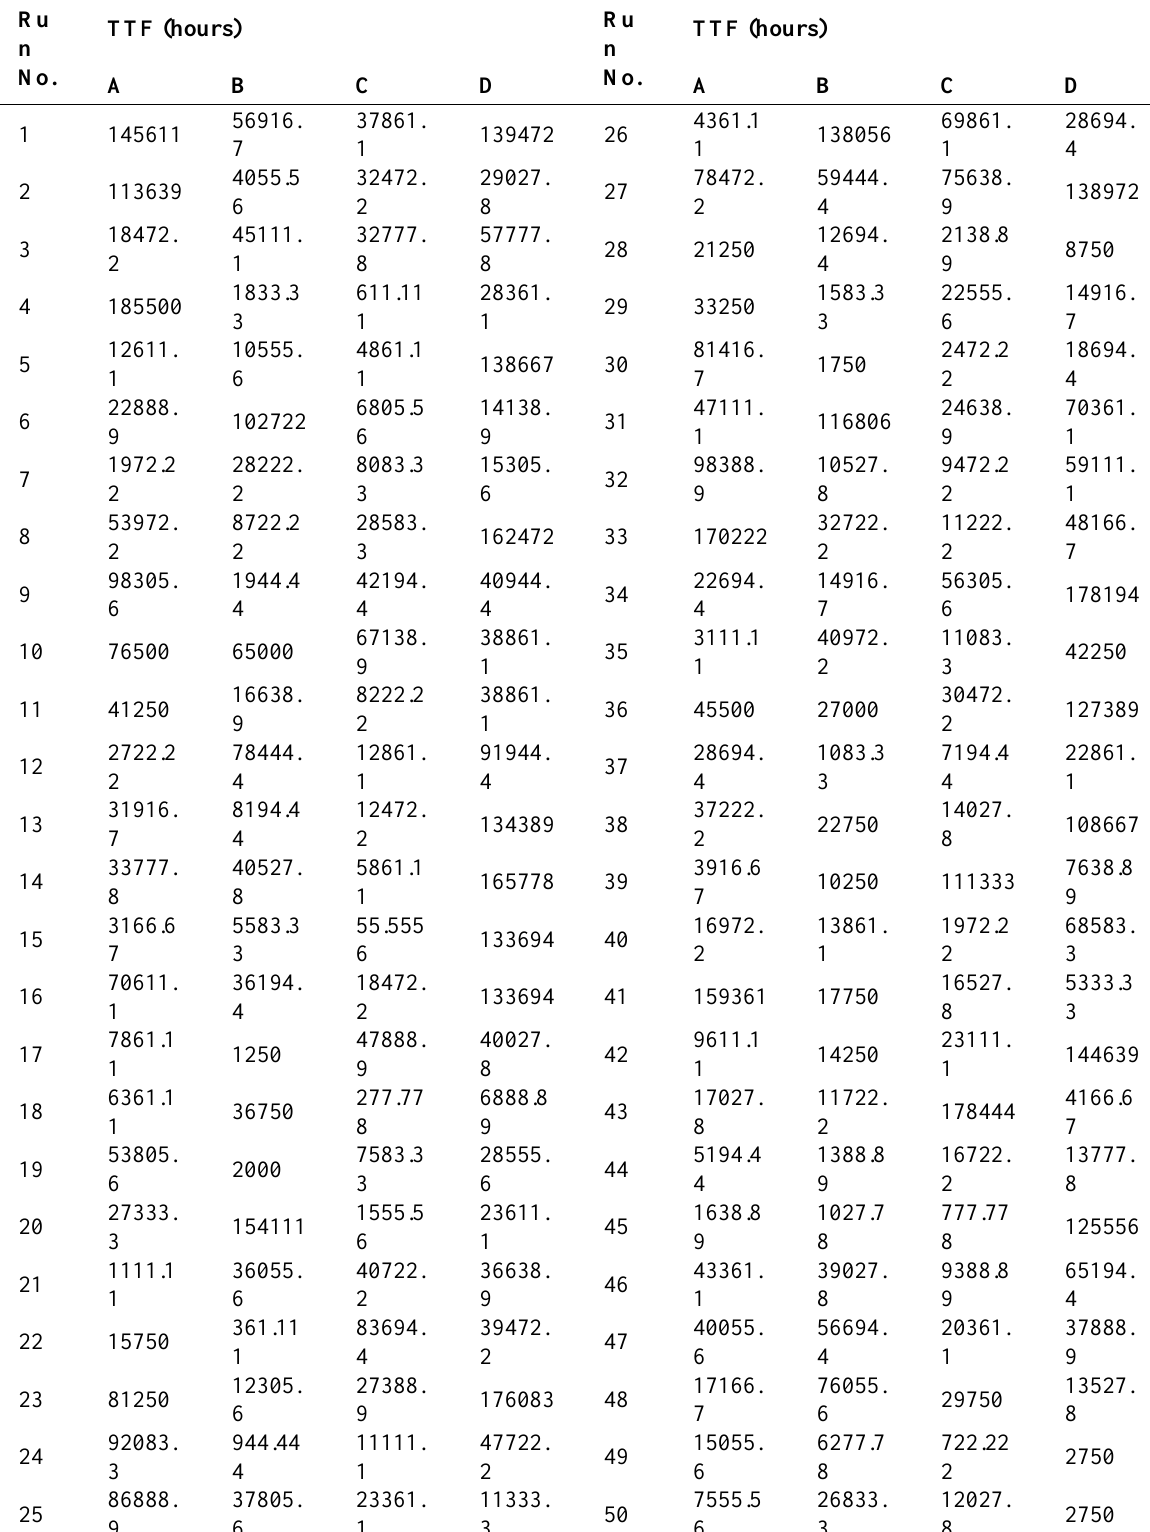
Table 3. Simulated life Time to Failure (TTF) results of 50-component simulation runs of the Eexample